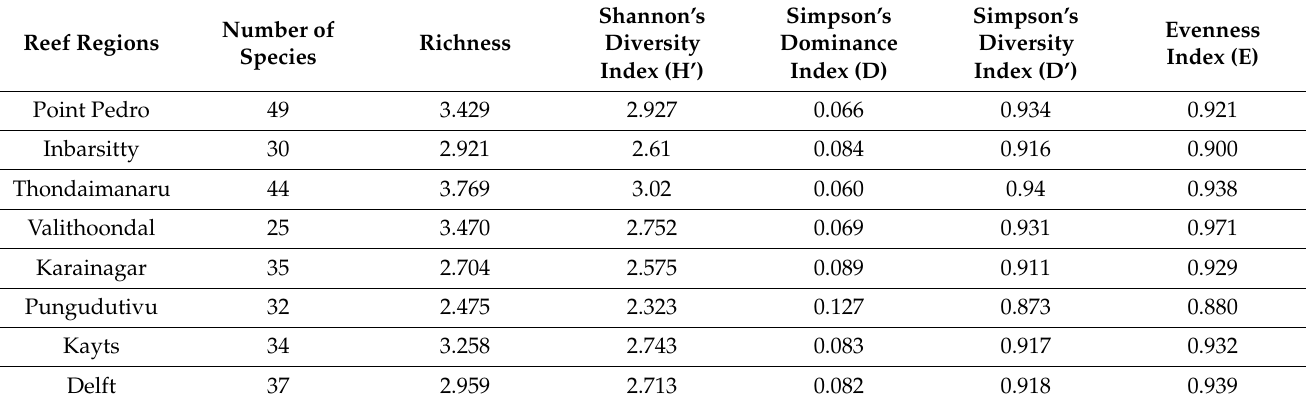
Table 4. The richness and values of diversity and evenness indices for hard corals at each of the study sites of the Jaffna Peninsula.